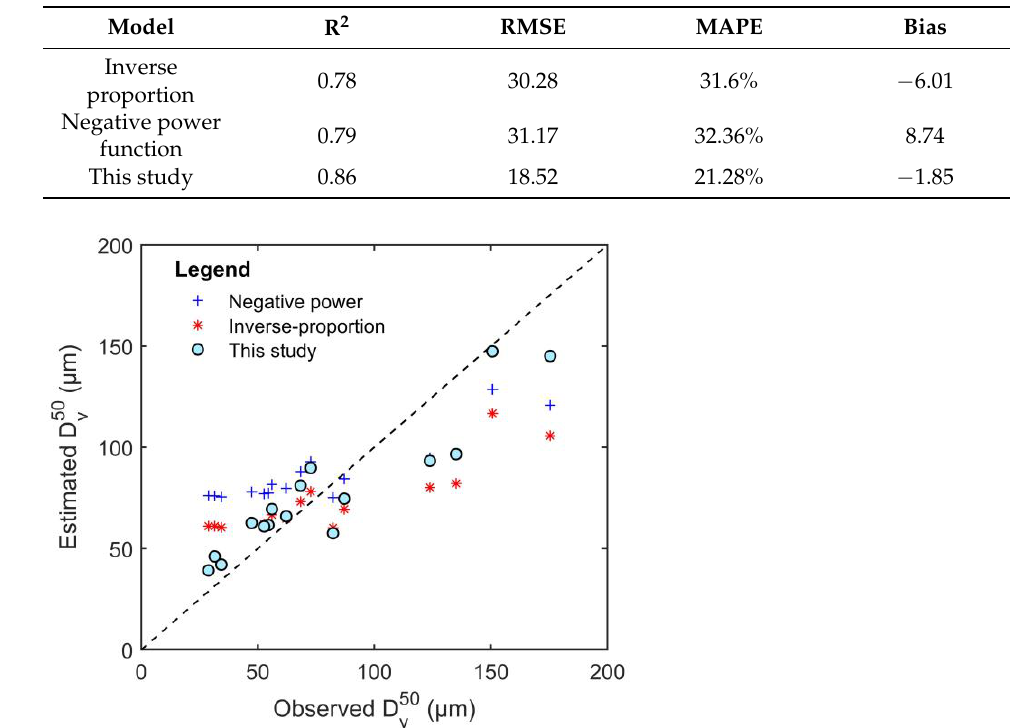
Table 4. Performance comparison of Dv50 models reported by previous studies and that proposed in this study in validation.